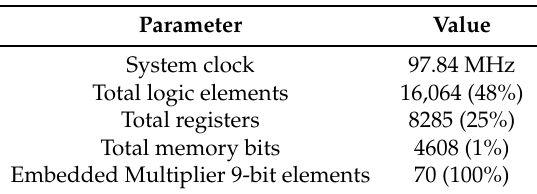
Table 1. Synthesis